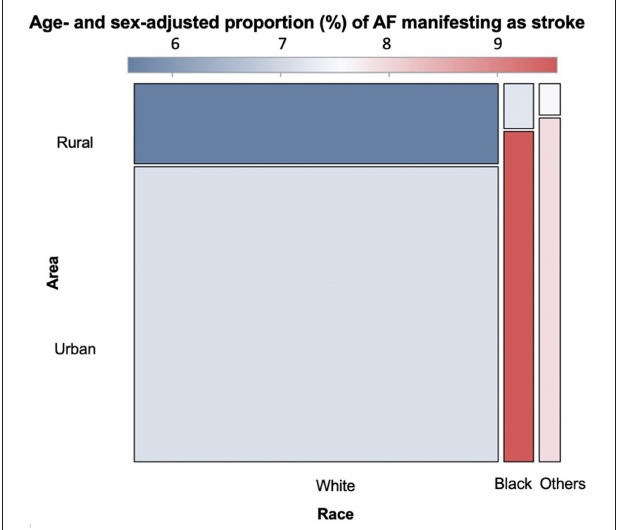
FIGURE 1 | Age- and sex-adjusted proportion (%) of newly diagnosed atrial fibrillation patients with ischemic stroke as the first manifestation of atrial fibrillation by race and urban/rural residence. The x axis shows three race/ethnicity categories (White, Black and Others) and the y axis shows urban and rural areas. Each of the 6 boxes presents one race-area group (White-Urban, White-Rural, Black-Urban, Black-Rural, Others-Urban, and Others-Rural). The size of the box represents the sample size of each group. Dark blue indicates the lowest proportion of AF diagnosis manifesting as stroke, while dark red represents the highest proportion of AF diagnosis manifesting as stroke.